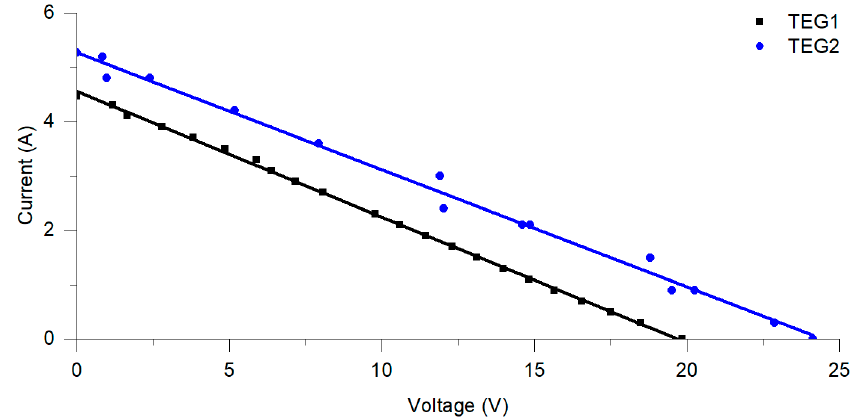
Figure 7. Current–voltage (I–V) characteristics of the tested TEGs.